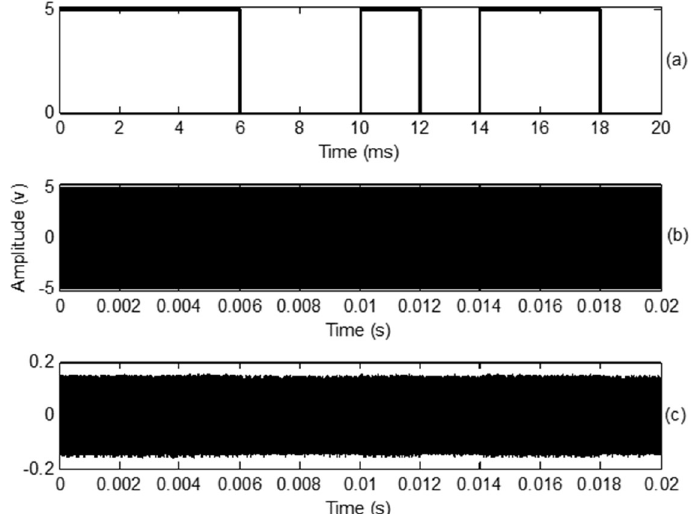
Figure 9. ( a ) Baseband digital signal at 500 bps; ( b ) Transmitted BFSK signal; ( c ) Received BFSK signal in water